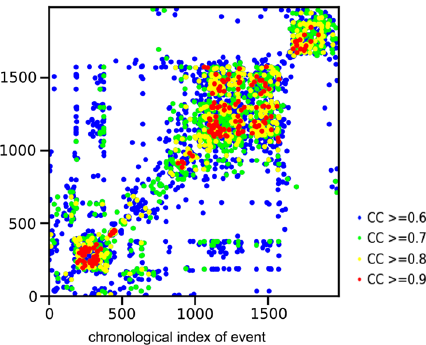
Fig. 4 Crosscorelation matrix showing cross-correlation values, for all event pairs calculated as a mean value across all 3 components. Only event pairs with crosscorelation values of 0.6 and higher are shown (adapted from Namjesnik 2021)